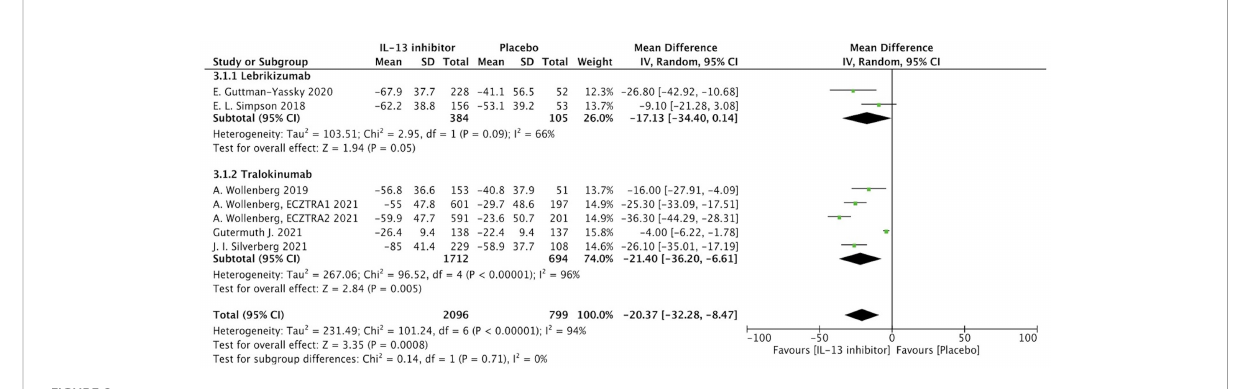
FIGURE 2 Forest plot for the percentage improvement of EASI score at the end of antagonizing IL-13 treatment.